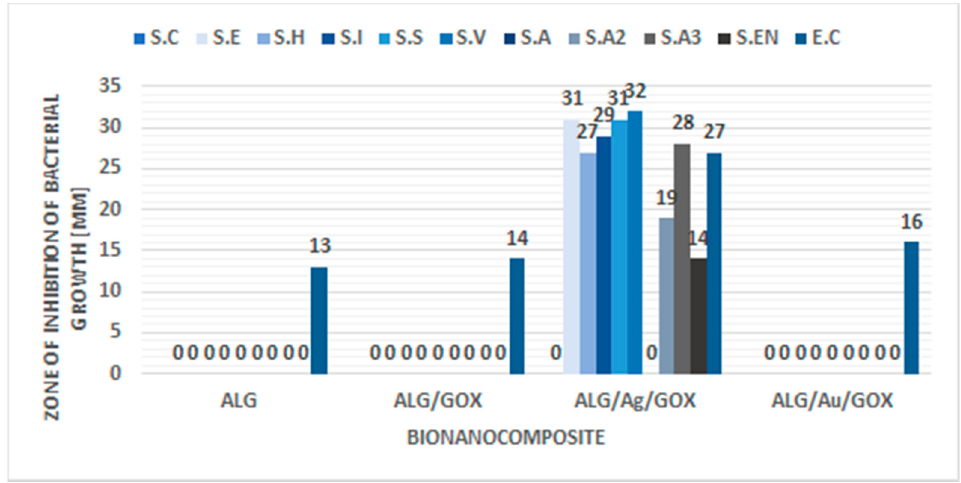
Figure 9. Growth inhibition zones for bacteria Staphylococcus capitis (S.C), Staphylococcus equorum (S.E), Staphylococcus haemolyticus (S.H), Staphylococcus lentus (S.L), Staphylococcus succins (S.S), Staphylococcus vitulinus (S.V), Staphylococcus aureus 1 (S.A), Staphylococcus aureus 2 (S.A2), Staphylococcus aureus 3 (S.A3), Salmonella enteritidis (S.EN), Escherichia coli